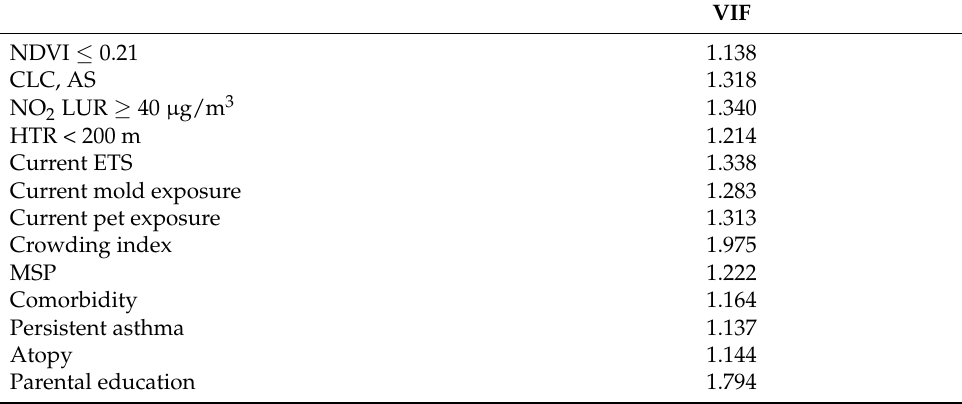
Figure 3. ORs and 95% CI of the mixed-effect logistic regression model for asthma control. No multicollinearity concern was identified (Table 3). Table 3. Variance Inflation Factor.